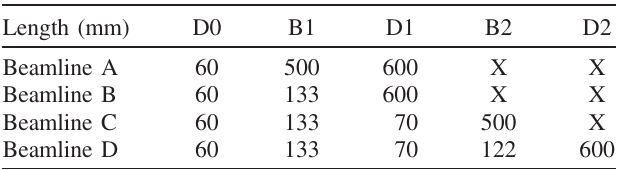
FIG. 9. Geometry for case H1.